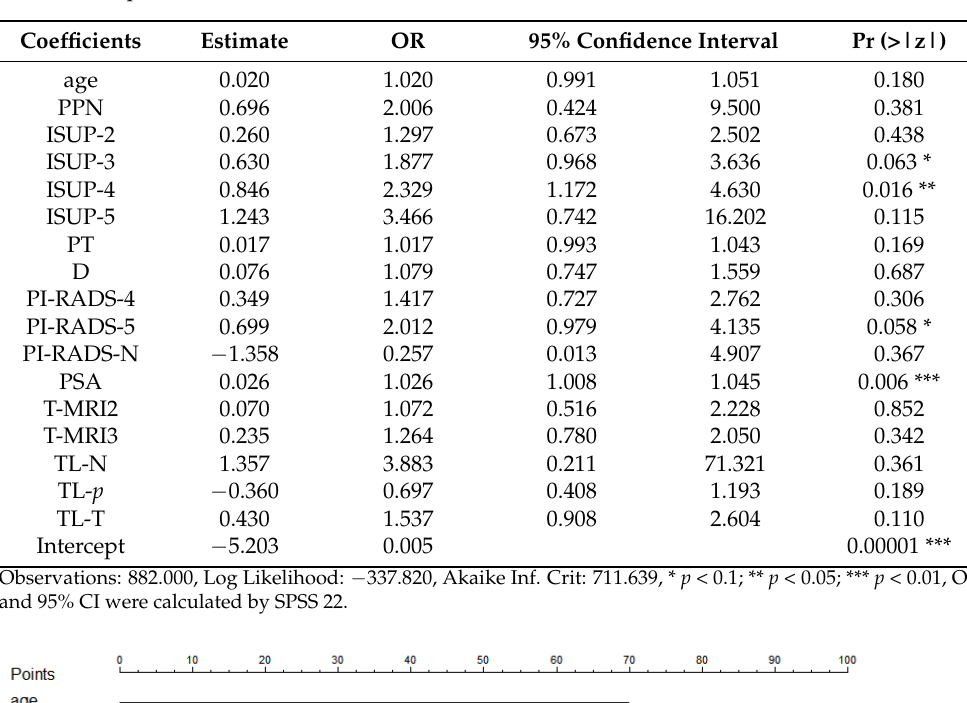
Table 3. The prediction model.